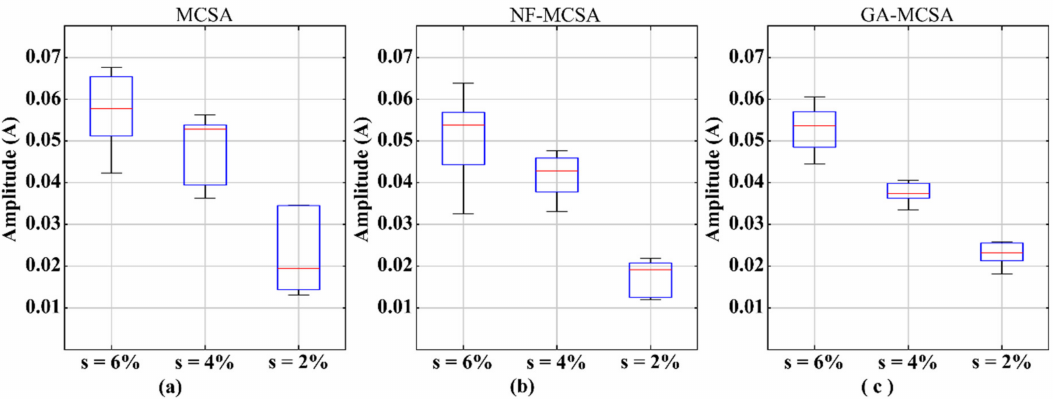
Figure 4. Boxplots for the amplitude results of the left side harmonic (LSH) at 31 Hz for the ( a ) common MCSA technique, ( b ) NF-MCSA technique, and ( c ) GA-MCSA